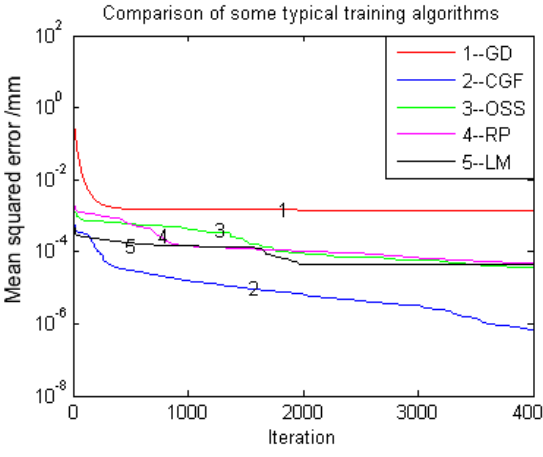
Figure 13. Performance of some typical training algorithms.